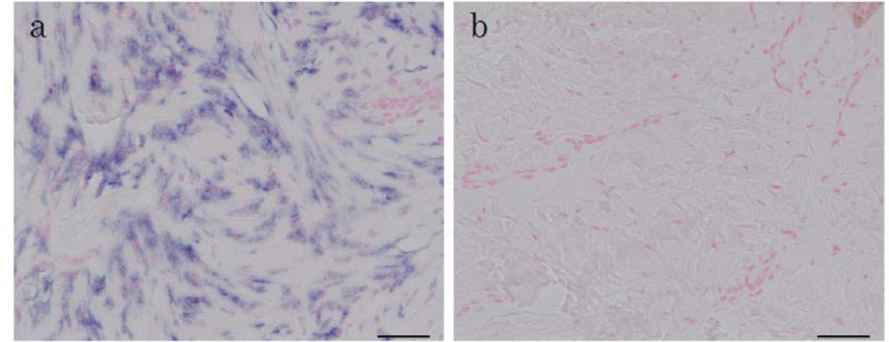
Figure 1. In situ hybridisation for HtrA1 mRNA in keloid and normal skin. Sections from active keloid lesions ( a ) or unaffected region ( b ) (patient No. 18 in Table 1) were hybridised with a probe specific to HtrA1 mRNA. Positive signals are visualised in blue. Scale bar = 50 µ m.